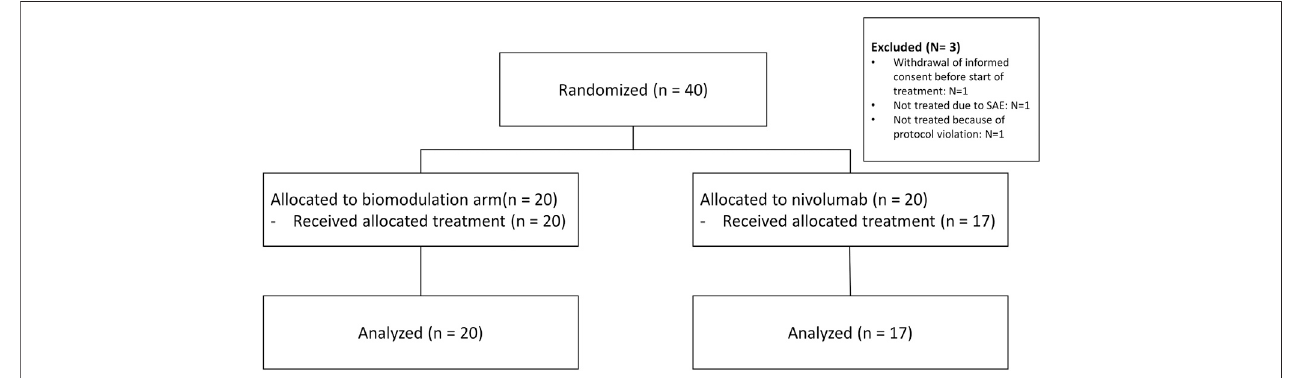
FIGURE 1 | CONSORT fl owchart of the ModuLung